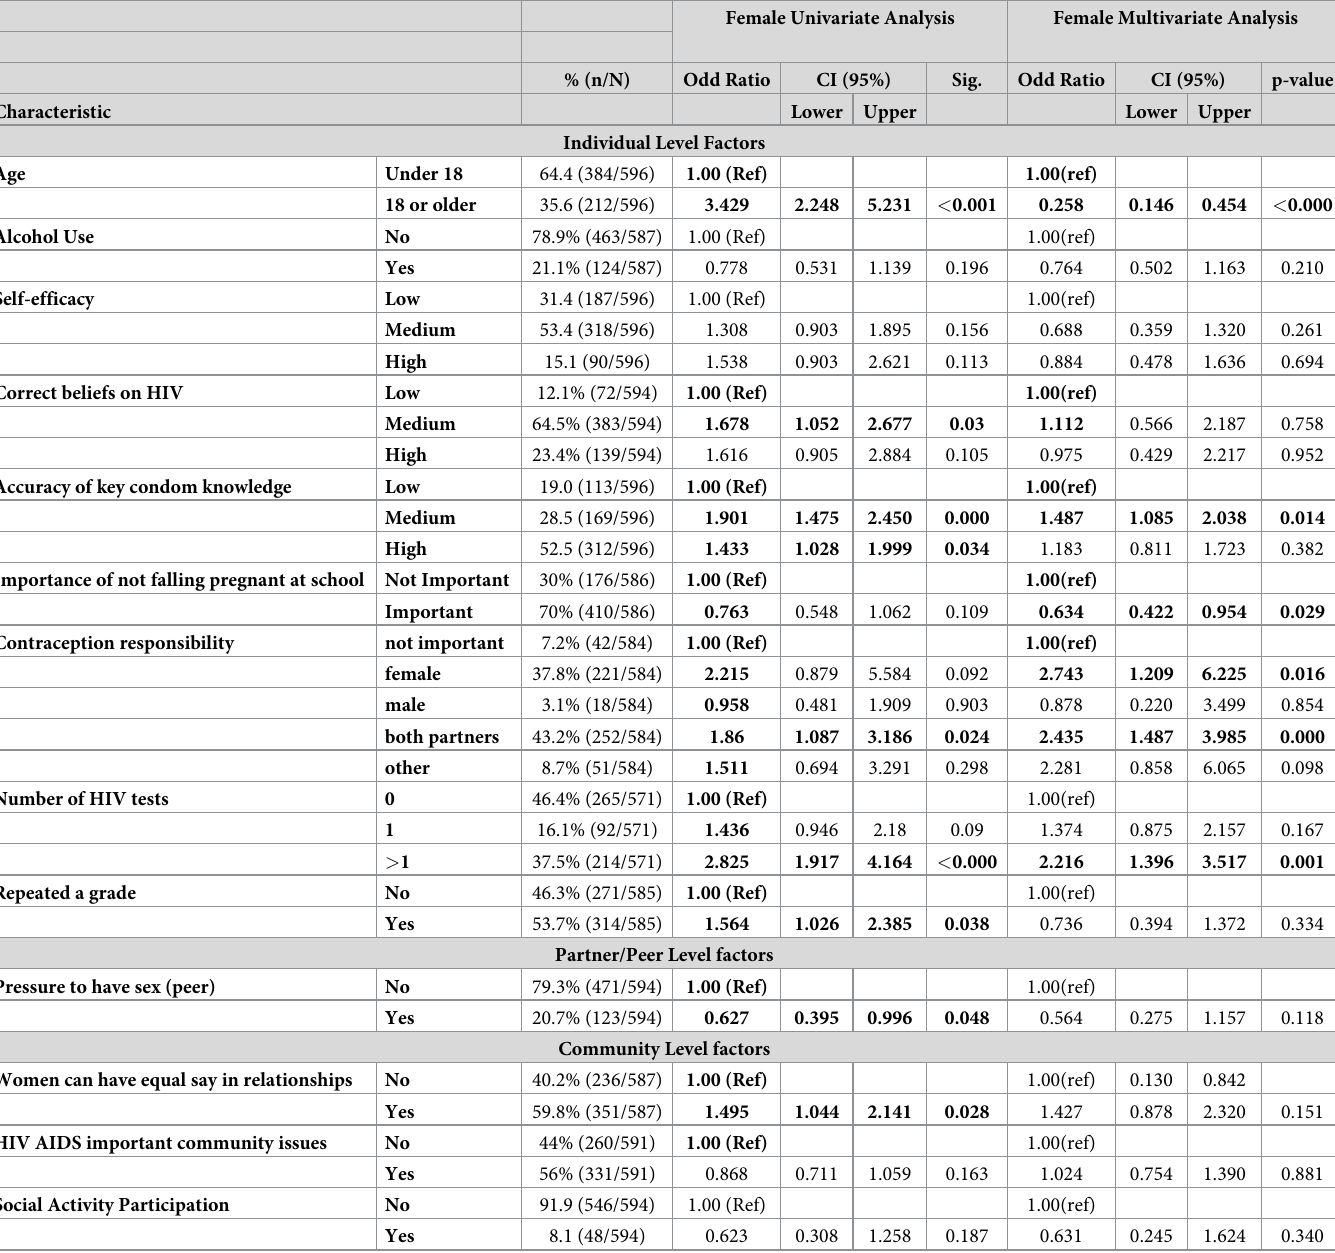
Table 2. Univariate and multivariate analysis of factors associated with SARU vs SARS profiles amongst learners in rural KwaZulu-Natal, South Africa @